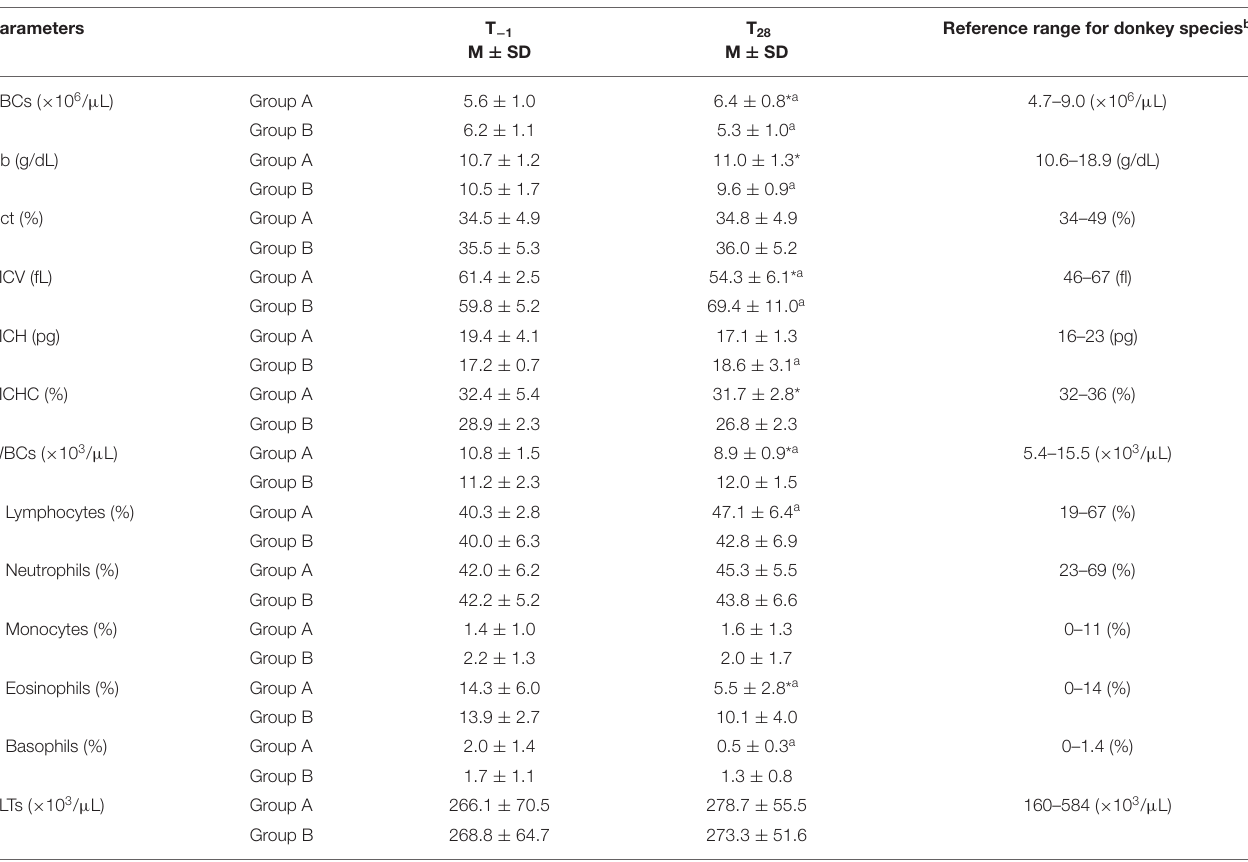
TABLE 3 | Mean values ± standard deviation (M ± SD) of red blood cells (RBCs), hemoglobin (Hb), hematocrit (Hct), mean corpuscular volume (MCV), mean corpuscular hemoglobin (MCH), mean corpuscular hemoglobin concentration (MCHC), white blood cells (WBCs) together with the leukocyte sub-population percentages, and platelets (PLTs) determined in treated (Group A, n = 11) and untreated (Group B, n = 11) donkeys before the first administration of the phytoterapic product (T − 1 ), and at the end of the trial (T 28